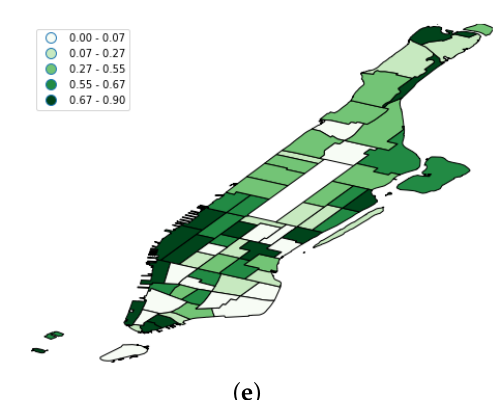
Figure 13. F1 score per taxi zone for each of the evaluated models. ( a ) FCNN F1 score per taxi zone; ( b ) LSTM F1 score per taxi zone; ( c ) RF F1 score per taxi zone; ( d ) SVM F1 score per taxi zone; ( e ) CRF F1 score per taxi zone.